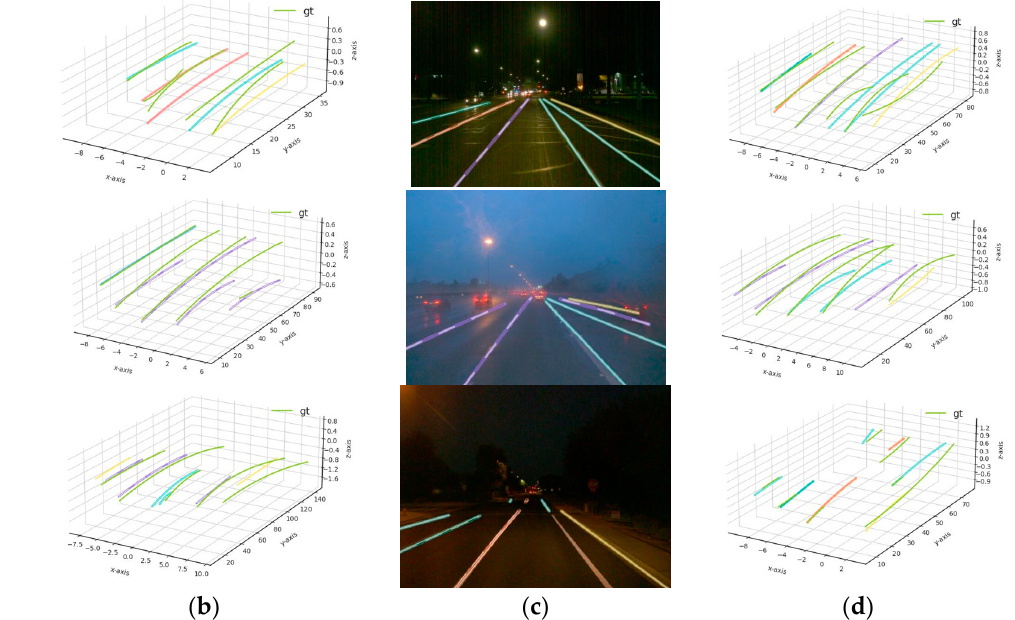
Figure 3. Results of 2D and 3D lanes obtained from the proposed method: ( a ) 2D results of extreme weather case; ( b ) 3D results of extreme weather case; ( c ) 2D results of night case; ( d ) 3D results of night case.